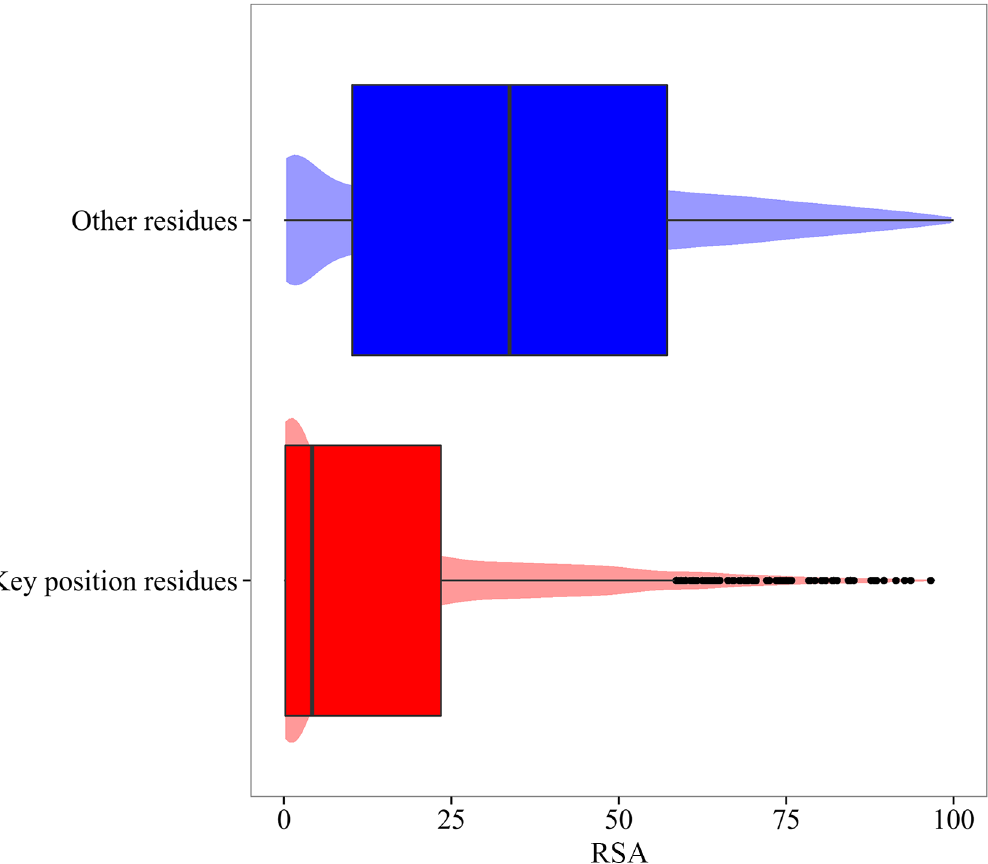
Fig 4. Relative accessible Surface Area (RSA) for key positions residues (red) and the rest of the positions in the protein